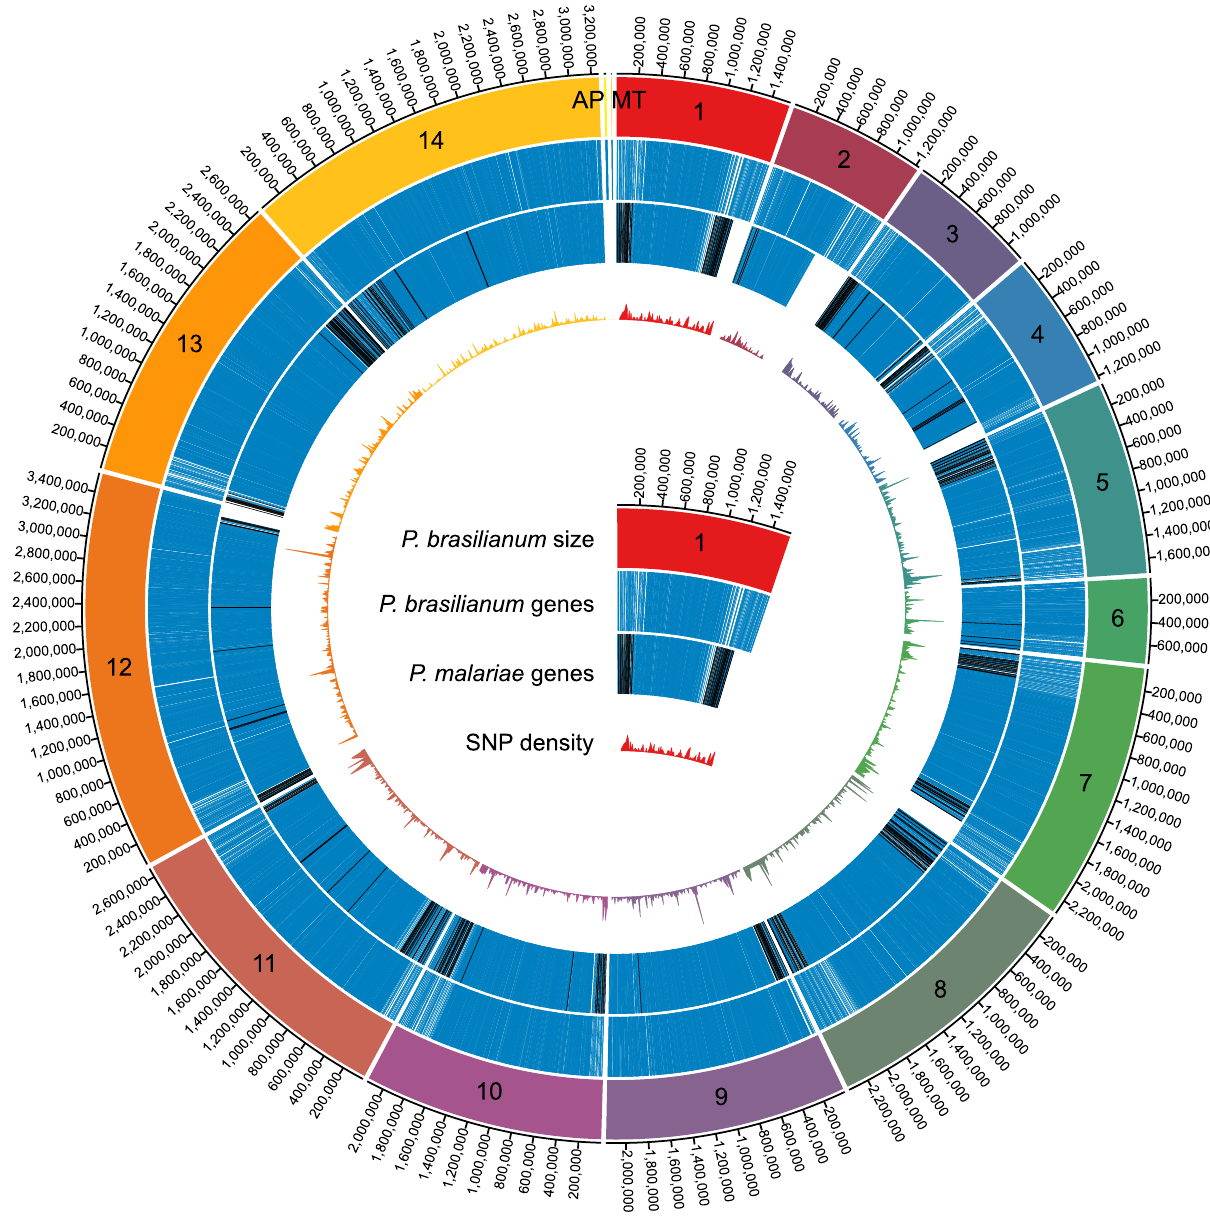
Figure 2. Genome organization of P. brasilianum and its variation from P. malariae. The four concentric rings, from outermost to innermost, show (1) the sizes and labels of the 14 P. brasilianum chromosomes, as well as the Apicoplast and Mitochondria; (2) the location of the 5,559 P. brasilianum genes (blue), excluding those on unplaced scaffolds; (3) the location of the 5,010 P. malariae genes (blue) and pseudogenes annotated onto the P. brasilianum genome through 80% or higher sequence similarity, excluding those on unplaced scaffolds; (4) line plot indicating SNP density of the 41,125 sequence variants between P. brasilianum and P. malariae sequences aligned by LASTZ alignment. The chromosome sizes and SNP density tracks are labeled with corresponding colors. The figure was generated using the Circa lengths between the two species, we see that the tetrapeptide repeat length in P. malariae from infected humans from Asia and South America lies in the range of 55–60 nucleotides, while the sequences from Africa show greater variability in repeat lengths (Fig. 4B). By contrast, csp sequences from non-human primate infected parasites, namely a Chimpanzee infected P. malariae and seven sequences from New World monkey infected P. brasilianum samples, had shorter repeat segments than human infected P. malariae and P. brasilianum samples. This presents an interesting finding, suggesting that CSP may play a role in host specificity and adaptation and provides a direction to pursue in future studies. In addition to csp , we evaluated the genome organization and sequence similarities between the P. brasi- lianum and P. malariae merozoite surface protein (MSPs) genes. MSPs genes mediate the initial contact stage of erythrocyte invasion by the parasite 25 . Of particular interest are the multifamily gene members of MSP3 and